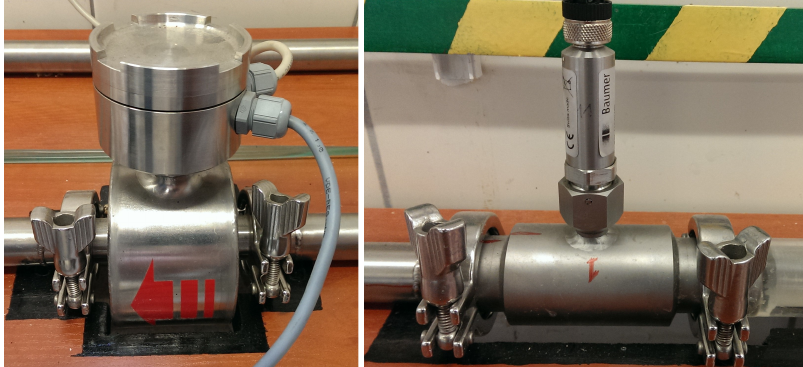
Figure 2. Electromagnetic flowmeter and static pressure piezoelectric